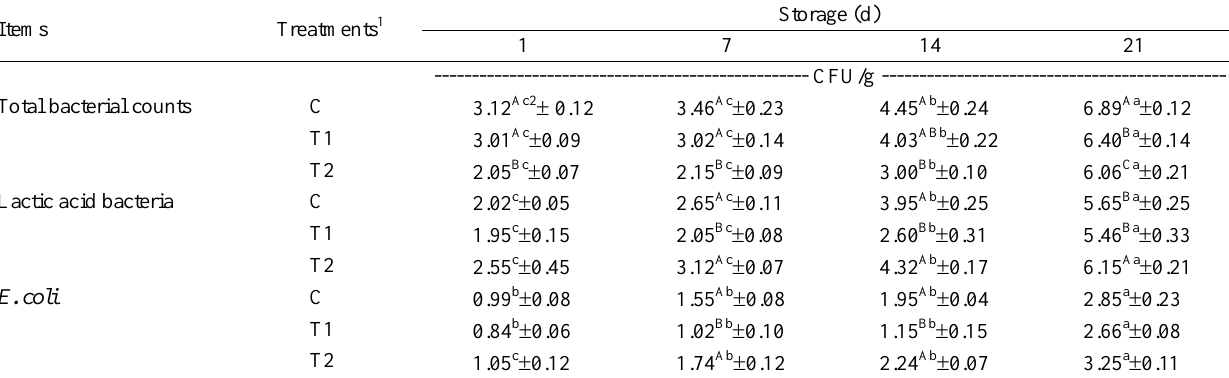
1 C: ziplock bag packaging, T1: vacuum packaging, and T2: MAP (CO 2 A-C Means  SD with different superscripts in the same column differ significantly at p<0.05. a-c Means  SD with different superscripts in the same row differ significantly at p < 0.05.